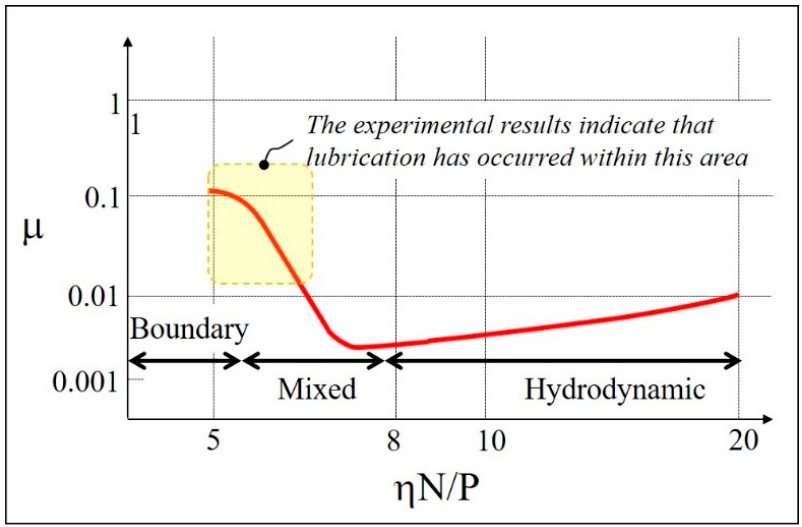
Figure 11. The relationship among the rotating velocity, friction coefficient, and lubrication regimes in the Stribeck curve of a journal bearing.